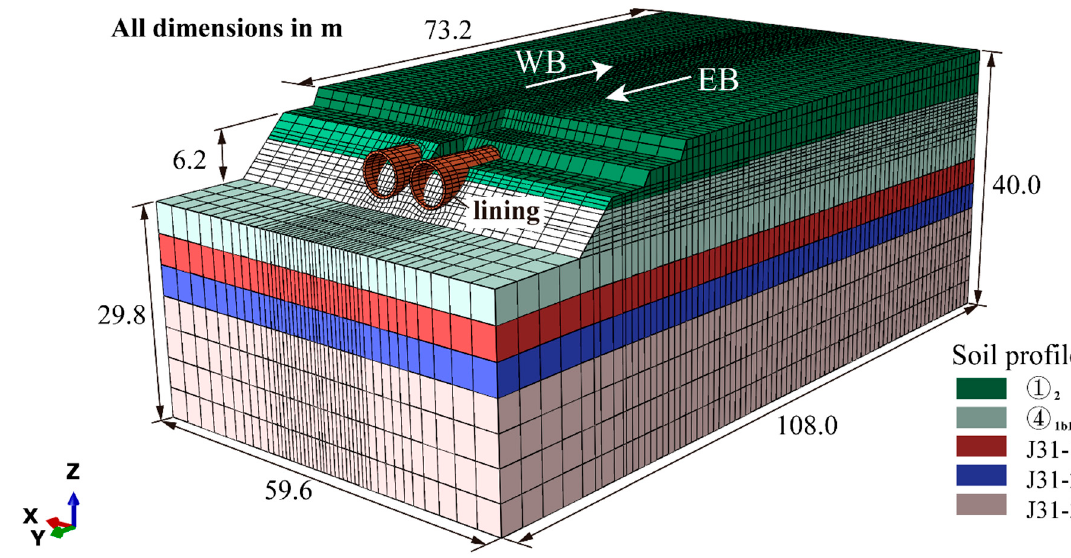
Figure 5. Geometry of the finite element analysis (FEA) model ( redrawn after [34]).